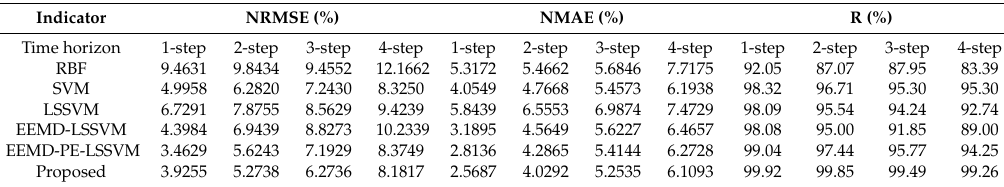
Table 6. The values of NRMSE, NMAE and R for six models in Dataset C.